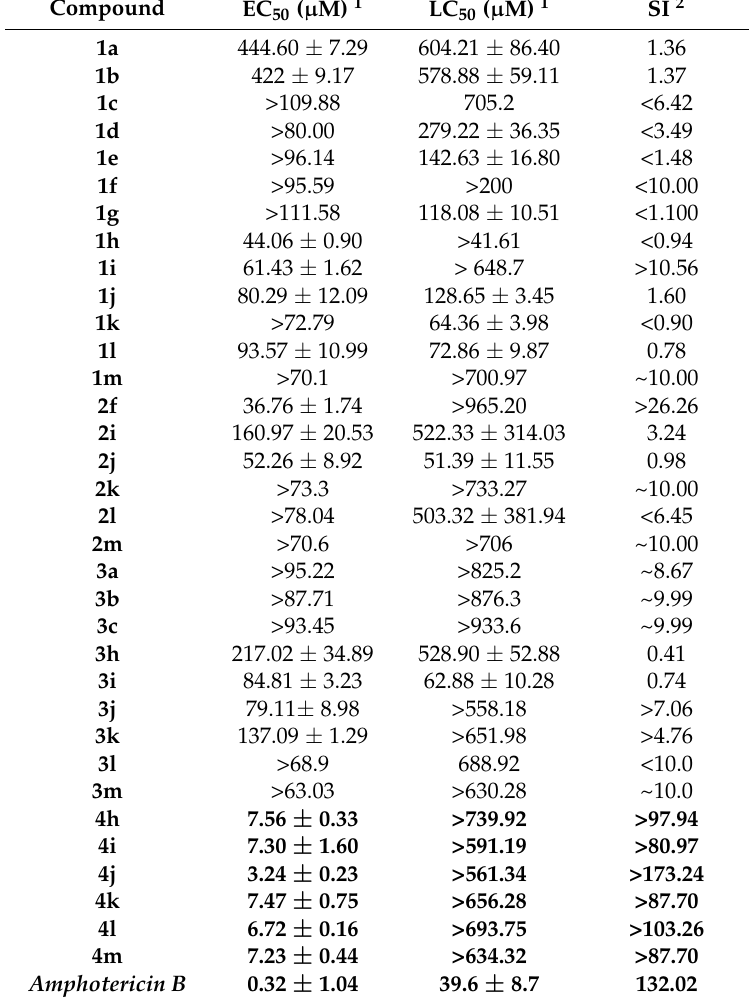
Table 1. In vitro antileishmanial and cytotoxic